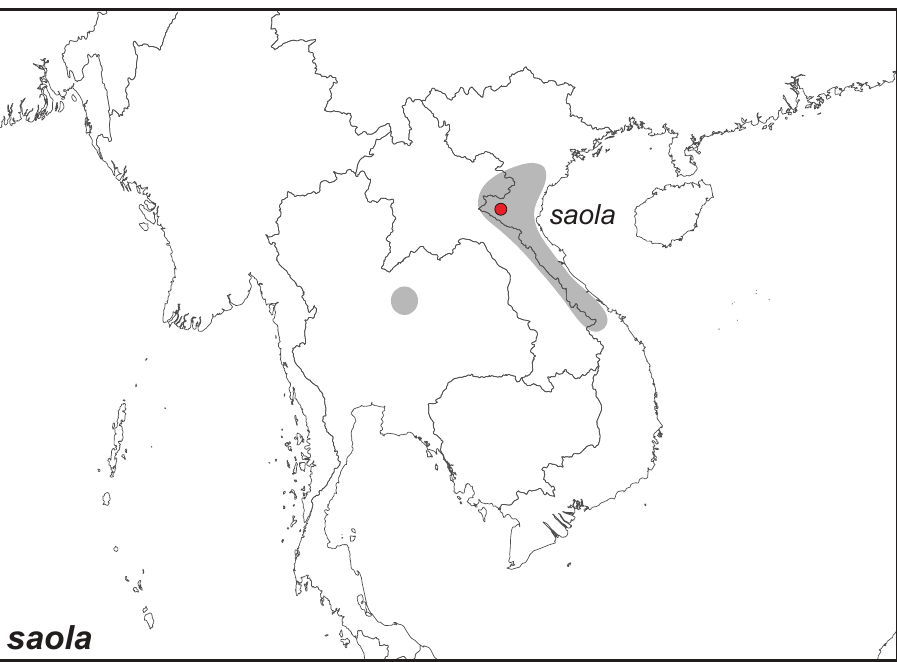
Figure 60. Distribution map of Elymnias saola